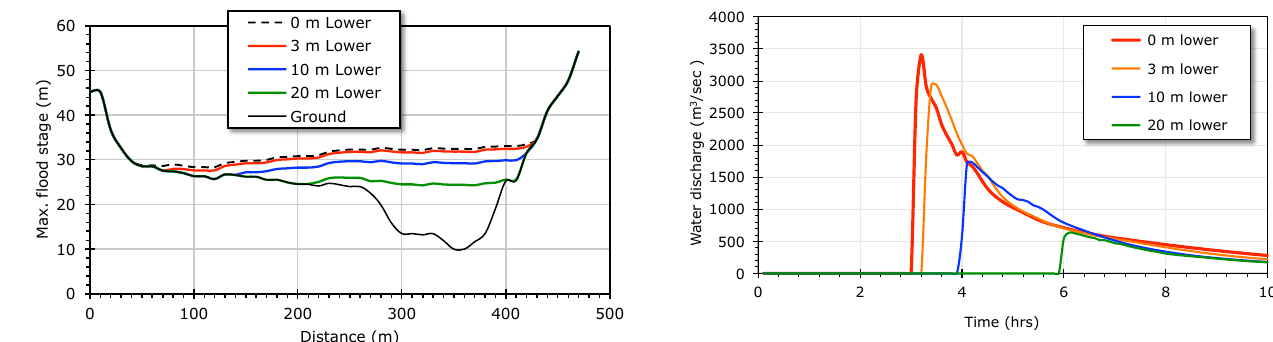
Figure 9. GLOF flood stage at Dingboche under current lake conditions for 0 m (Expected), 3 m, 10 m and 20 m lake lowering scenarios.